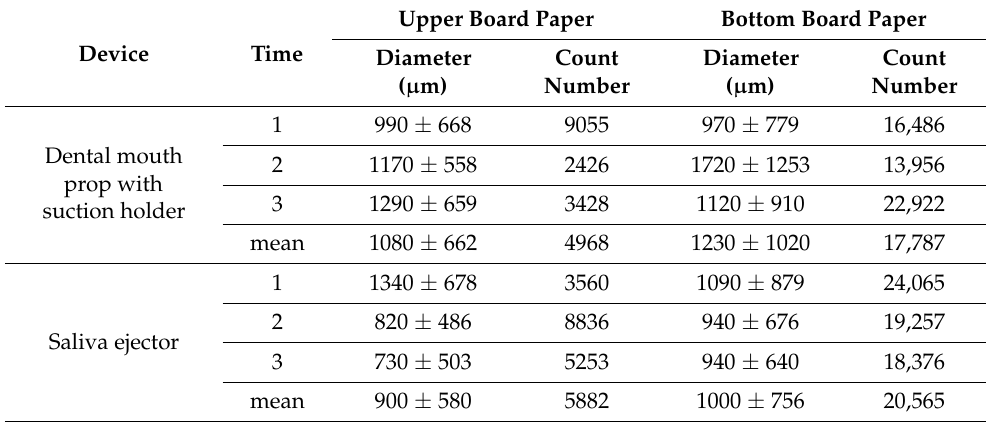
Table 1. The mean ± standard deviation diameter (micrometer) of the aerosol and spatter particle and count number between the two